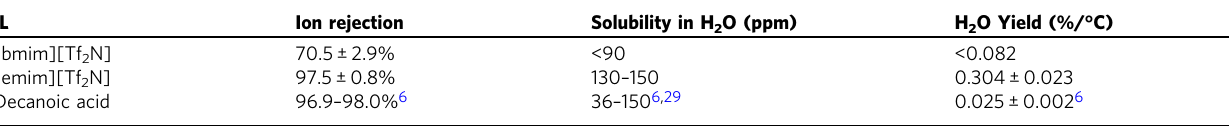
Table 1 TSIL DSE desalination performance a